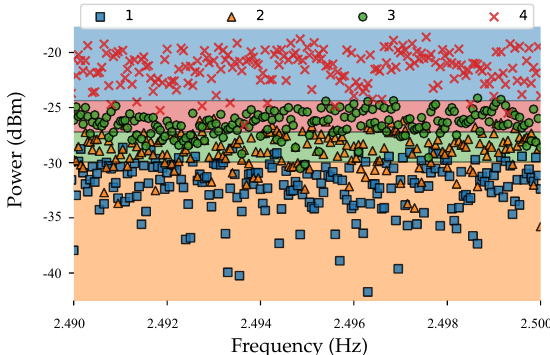
Figure 5. Shape classification using RBF kernel SVC methods (square (1), triangle (2), circle (3), and rectangular